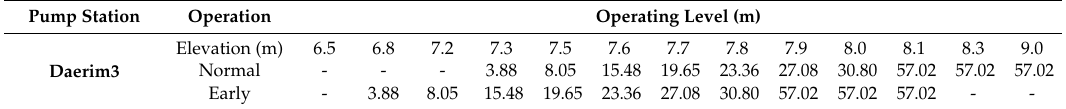
Table 3. Normal and early operation of the centralized reservoir in the study area [28].